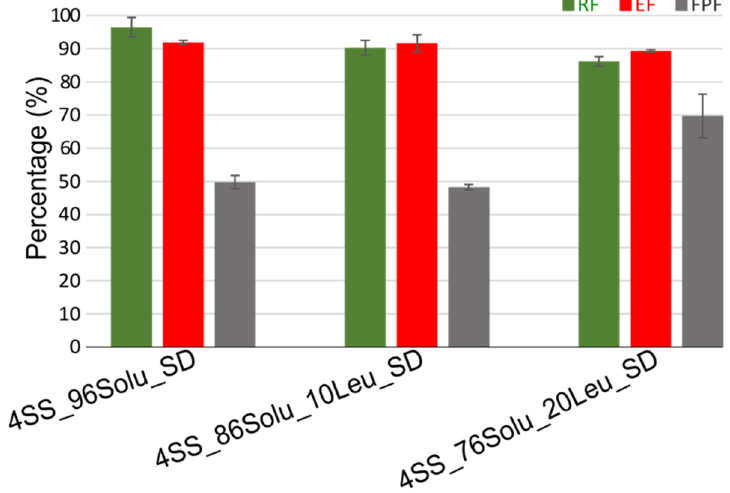
Figure 6. Aerosol performance of the various spray-dried formulations (4% salbutamol/96% soluplus (4SS_96Solu_SD), 4% salbutamol/86% soluplus/10% leucine (4SS_86Solu_10Leu_SD), and 4% salbutamol/76% soluplus/20% leucine (4SS_76Solu_20Leu_SD)).